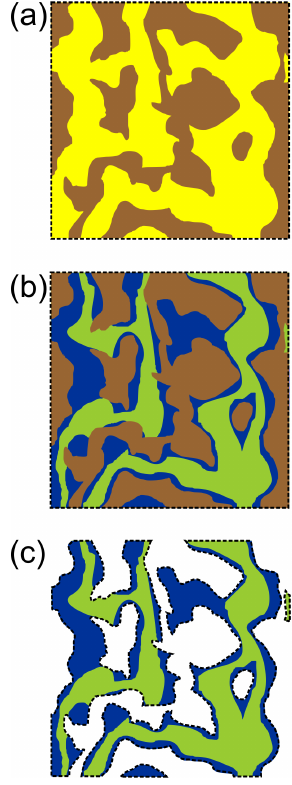
Figure 2. Sets and subsets of a three-phase medium using a 2-D slice to represent the whole 3-D medium. (a) Two phases: Phase 1, brown, representing solid matrix; Phase 2, yellow, represents pore space, with unspecified fill. Phase fractions and connectednesses can be defined for each phase with respect to the whole medium (dotted box). (b) Three phases created by filling (replacing) the porosity with two phases: Phase 1, brown, representing solid ma- trix as before; Phase 2, blue, representing water; Phase 3, green, representing oil. Phase fractions and connectednesses can be de- fined for each of the three phases with respect to the whole medium (dotted box). (c) If only the pore space is considered by considering Phase 1 to be unchanging, what remains is a two-phase subset of the three-phase situation. Phase fractions and connectednesses can be defined for the two fluid phases with respect to the subset which is the porosity (inside the dotted